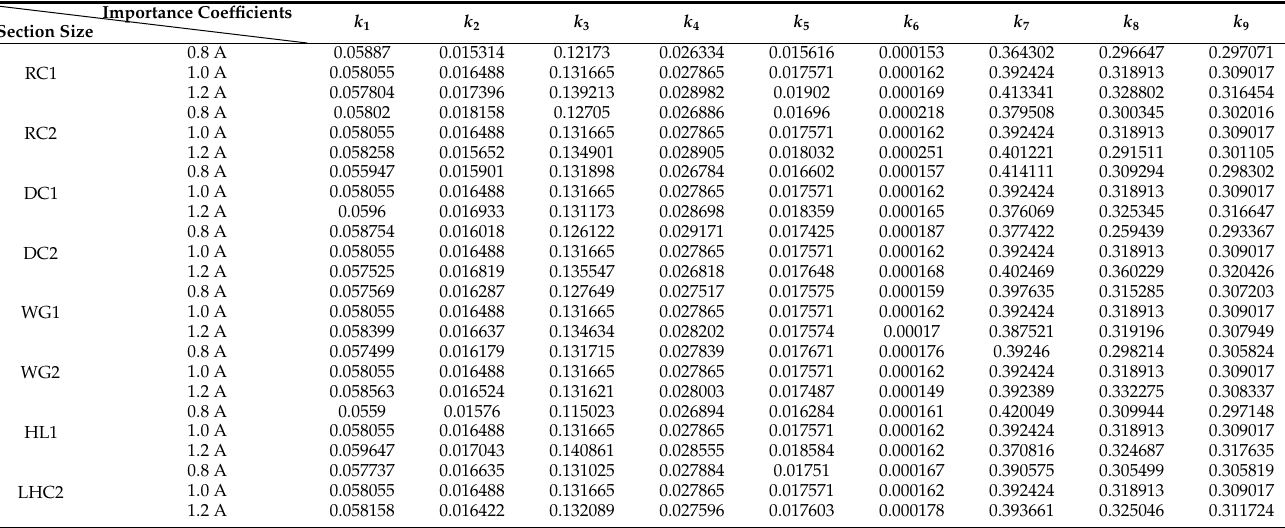
Table 4. Importance coefficients of the elements under different areas of the element